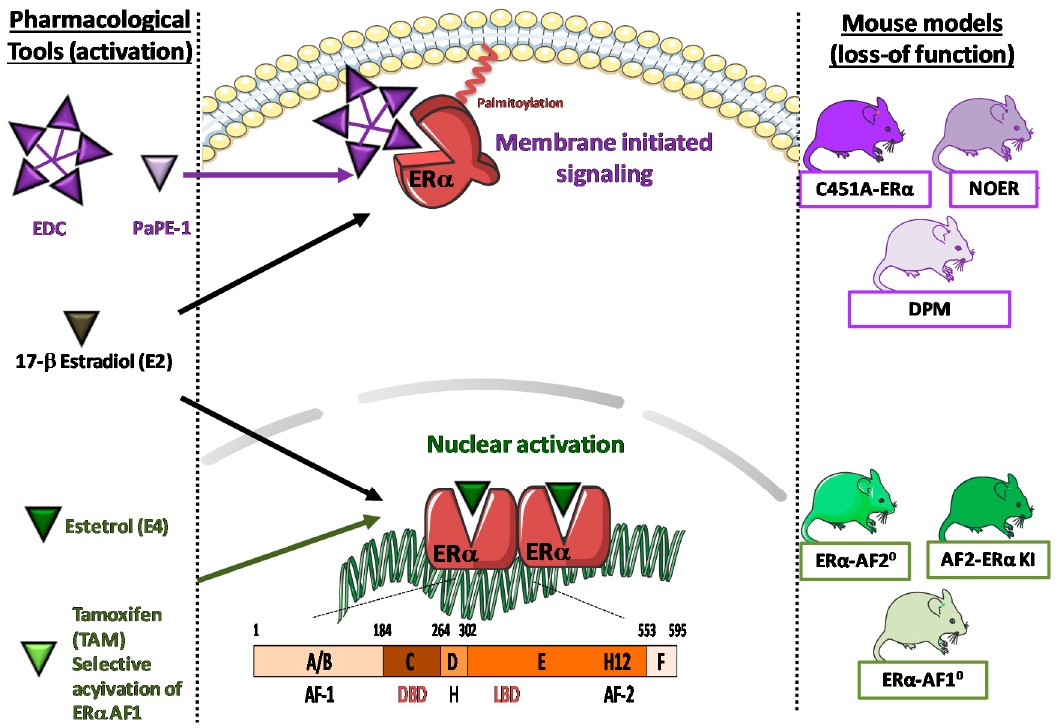
Figure 2. Nuclear/genomic effects of ER α . Nuclear/genomic and rapid extra-nuclear membrane actions (MISS) of ER α are presented in the middle panel, with loss of function mouse models (on the right ) and estrogenic compounds (on the left ) activating both nuclear and membrane ER α (E2), selective activation of either extra-nuclear actions of ER α (EDC, Estrogen-Dendrimer Conjugate andPaPE, Pathway Preferential Estrogens) or nuclear actions of ER α (E4, estetrol) or the Selective Estrogen Receptor Modulator (SERM, such as tamoxifen).